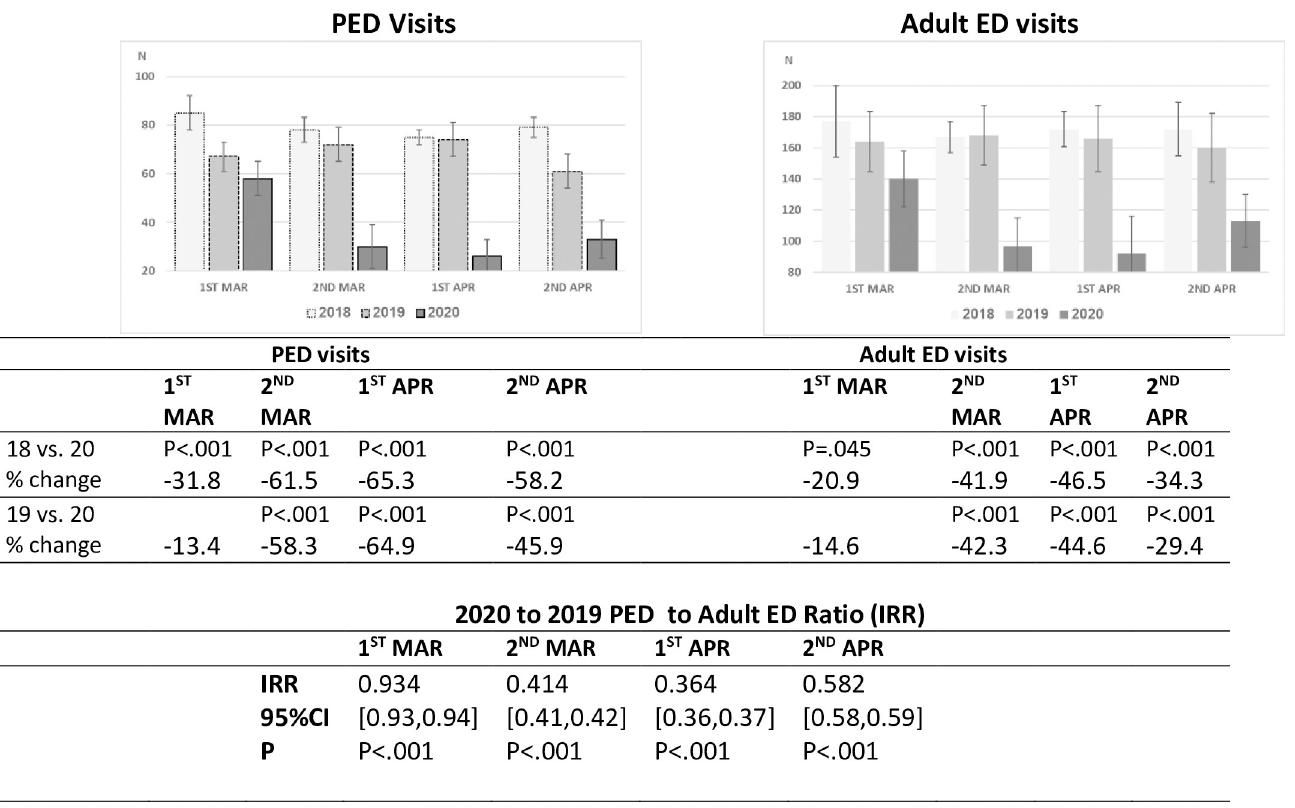
Fig 2. PED and adult ED mean daily visits, March and April 2018–2020, half-month periods. The decline in PED and adult ED mean daily visits started in the second half of March and continued significantly during the next three periods. The comparison of IRR for PED and adult ED visits between 2019 and 2020, shows that the decline in visits in the late three periods was higher in PED than in adult